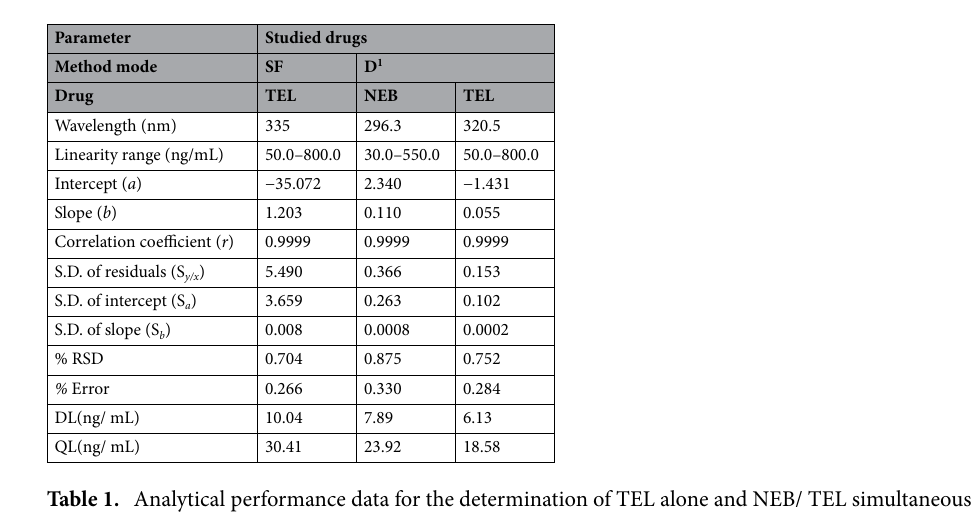
Table 1. Analytical performance data for the determination of TEL alone and NEB/ TEL simultaneously by the proposed methods.